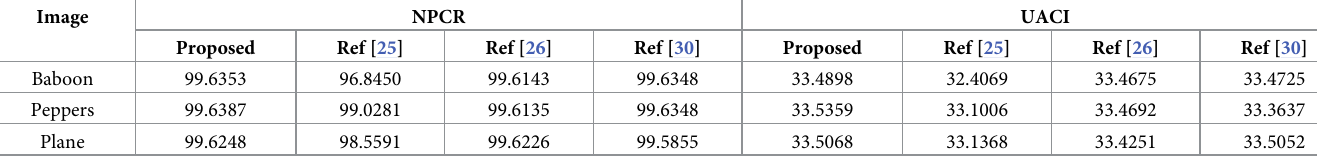
Table 7. Comparison of NPCR and